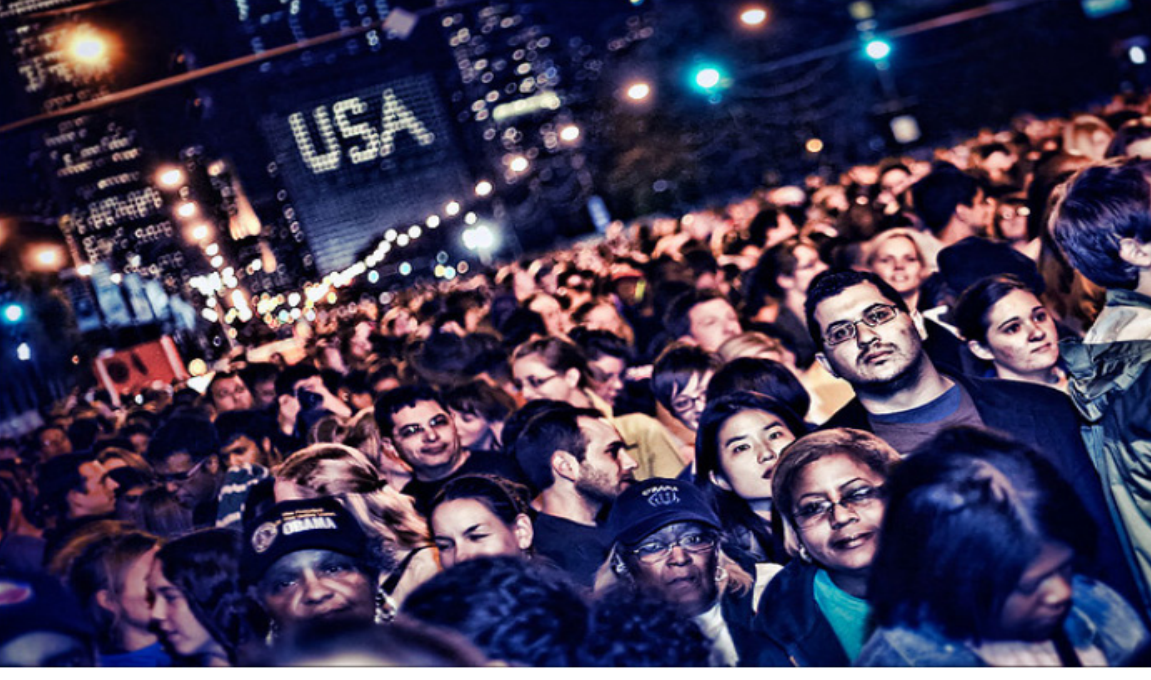
Mean scores of men and women and users and librarians were analyzed using a t -test with